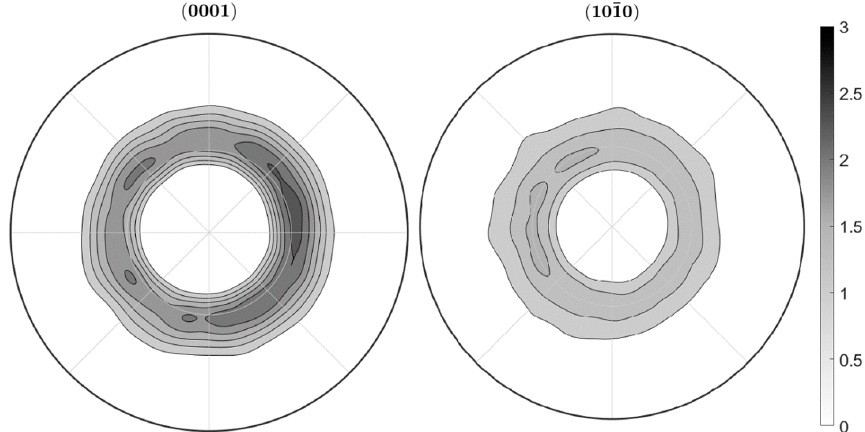
Figure 3. X-ray diffractometer (XRD) pole figures of the EX sample (cross-section).